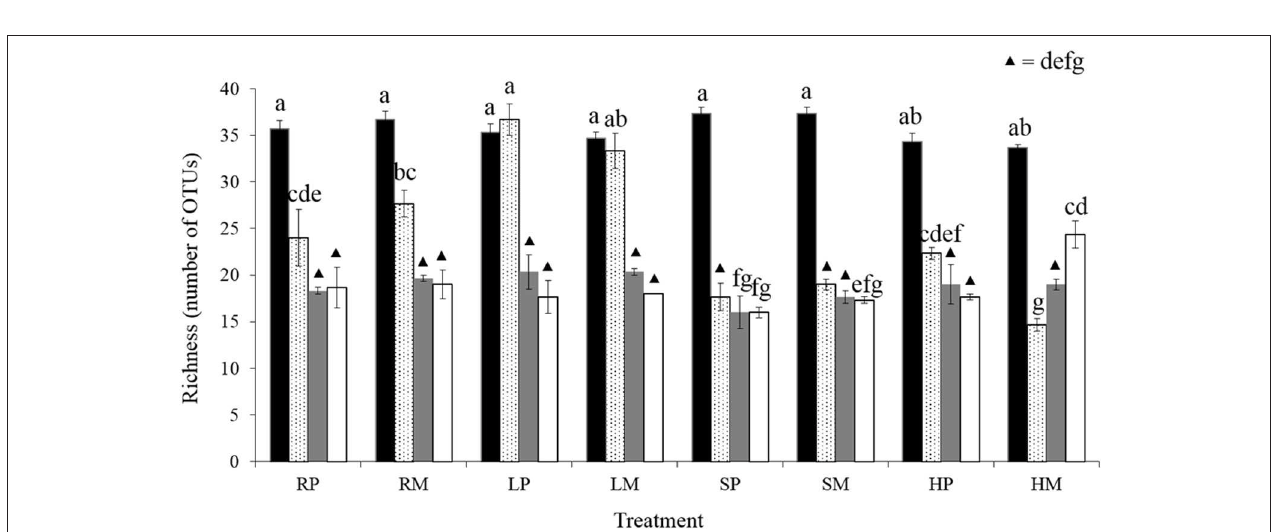
FIGURE 4 | Community richness over time. Richness was assessed by ARISA on three communities per treatment and per cycle. Black, cycle 3; dotted, cycle 7; gray, cycle 10; white, cycle 14. Bars represent SE. Different letters represent significant differences (Tukey HSD test; p < 0.05). P, Propagule; M, Migrant pool; R, Random: L, Low; S, Stabilizing; H,